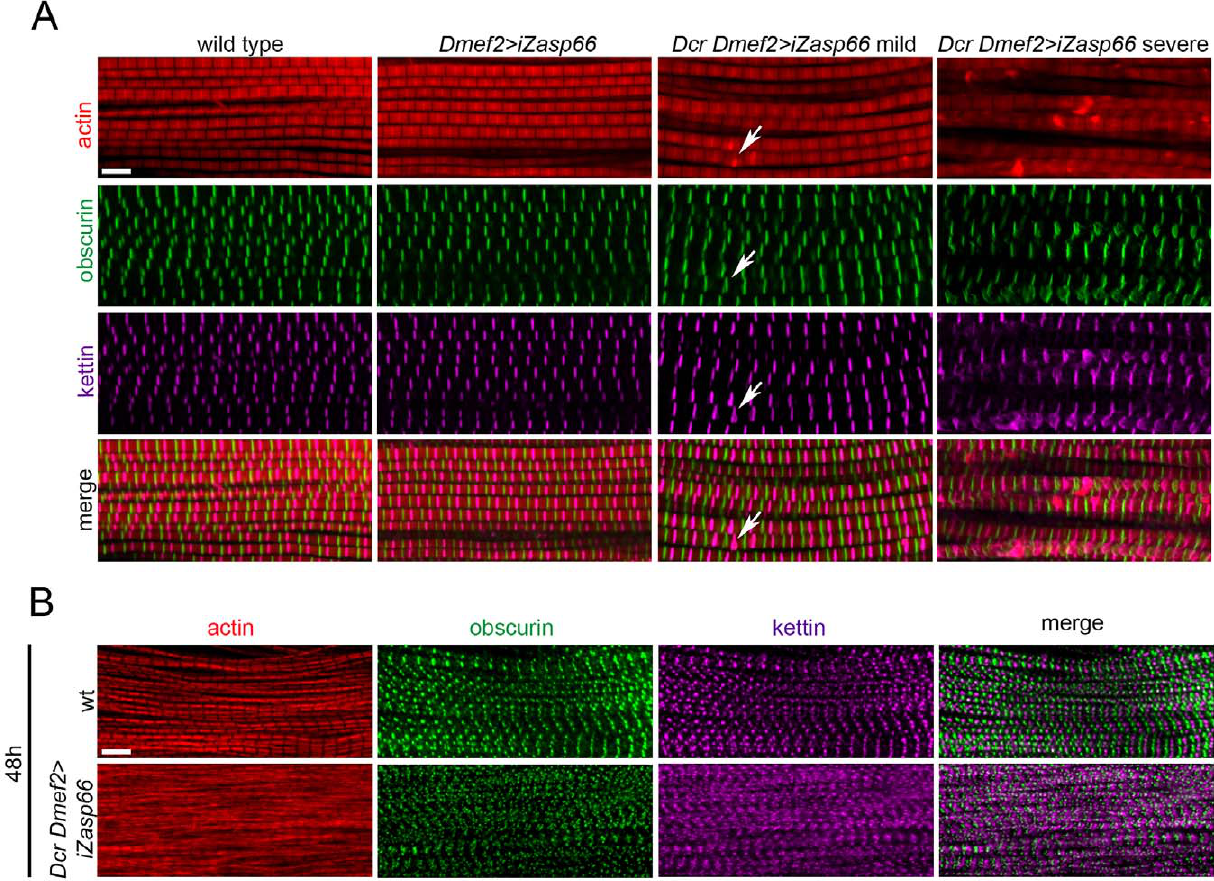
Figure 7. Zasp66 depletion affects adult IFM structure and pupal myofibril development. (A) Adult IFM myofibrils of wild type and Zasp66 knockdown flies stained with phalloidin (red), anti-obscurin (green), and anti-kettin (magenta) antibody. Dmef2 . iZasp66 myofibrils show no defects with perfectly arranged sarcomeres. The majority of Dmef2 . iZasp66 flies enhanced with Dcr show mild myofibrillar abnormalities. Occasionally distorted M-lines and Z-discs are present (arrows). In more severe cases the integrity of sarcomeres is lost, and M-lines and Z-discs are severely disrupted. (B) IFM of pupae 48 h APF of wild type and Dcr Dmef2 . iZasp66 flies stained with phalloidin (red), anti-obscurin (green) and anti-kettin (magenta) antibody. Myofibrils of Dcr Dmef2 . iZasp66 IFM are less structured, similar to what was observed in Dcr Dmef2 . iZasp52ex20 flies (Figure 4). Compared to wild type, obscurin and kettin appear less ordered. Scale bars, 5 m m.